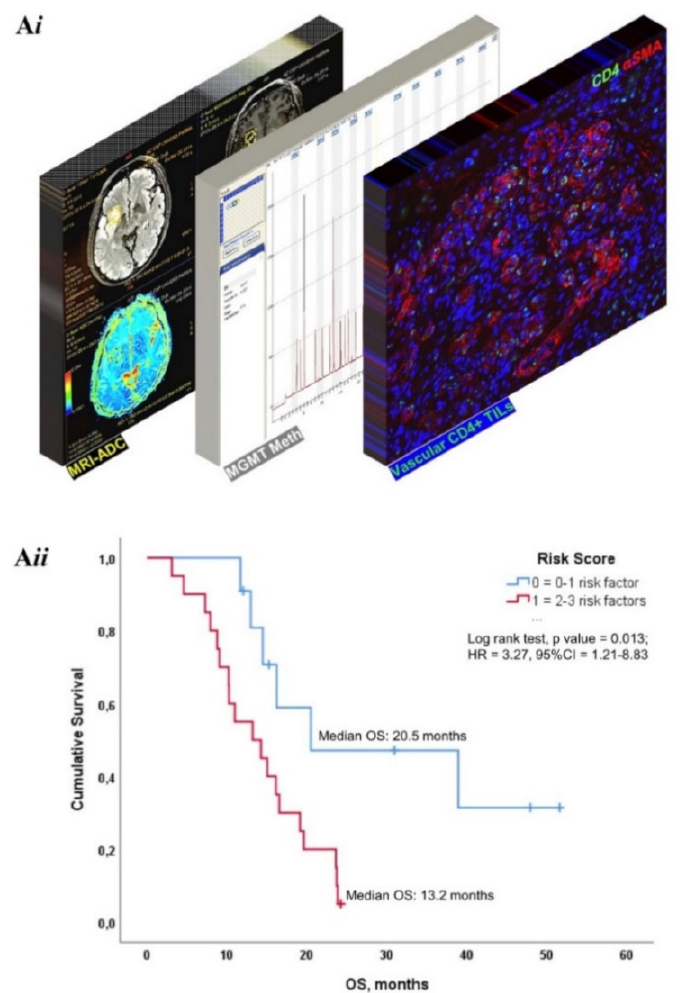
Figure 6. Highly Prognostic Integrated Risk Stratification Model. ( A i ): Schematic representation of our approach to generate a prognostic score interlacing MRI-derived ADC value, MGMT methylation status and the incidence of vascular CD4+ lymphocytes, as pre-determined risk factors. Representa- tive images of original data obtained from our patient cohort and adapted for illustrative